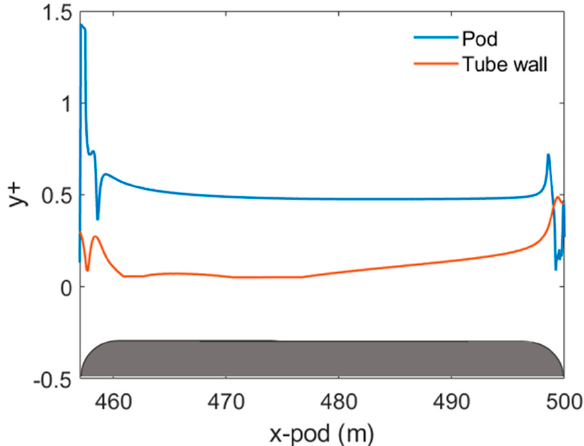
Figure 3. Variation of y + around the pod surface and tube wall at a pod speed of 350 m / s. The maximum y + was obtained at the nose of the pod.